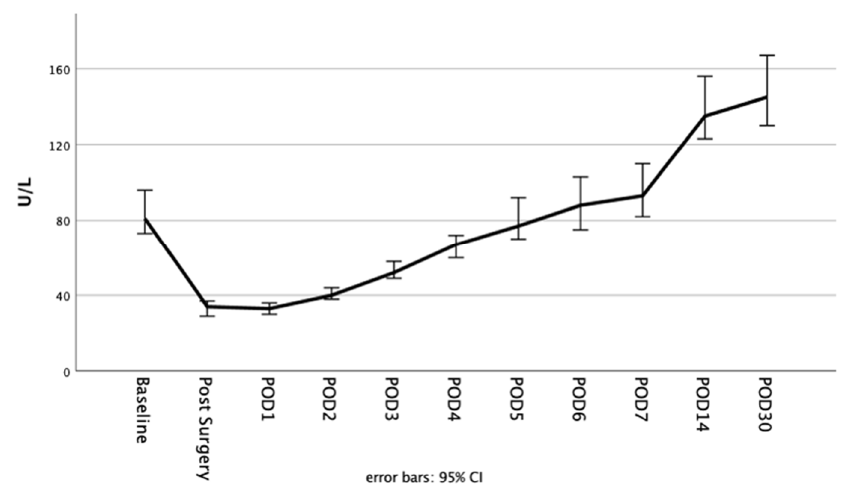
Figure 5. Postoperative course of alkaline phosphatase in the overall cohort until POD 30. With the exception of one, there was no significant difference regarding the index surgical procedure between the cohorts (Supplementary Data Table S2). Only the number of patients who underwent concomitant CABG and valve surgery was significantly higher in the greater AP drop cohort (24.5% vs. 38.1%; p = 0.032). While the total surgery time was significantly longer in these patients (9.17 (10.00, 6.92) vs. 9.63 (12.13, 8.02) in hours; p = 0.035), there was no statistically significant difference between CPB and ACC times ( p = 0.218 and p = 0.312, respectively). This might highlight the occurrence of